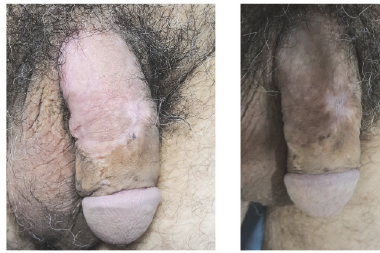
Figure 4: The tumor is characterized by prominent papillomatosis and acanthosis [haematoxylin-eosin stain, original magnification